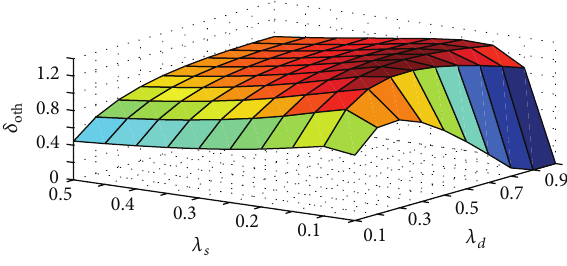
Figure 14: Effect of 𝜆 𝑠 and 𝜆 𝑑 on 𝛿